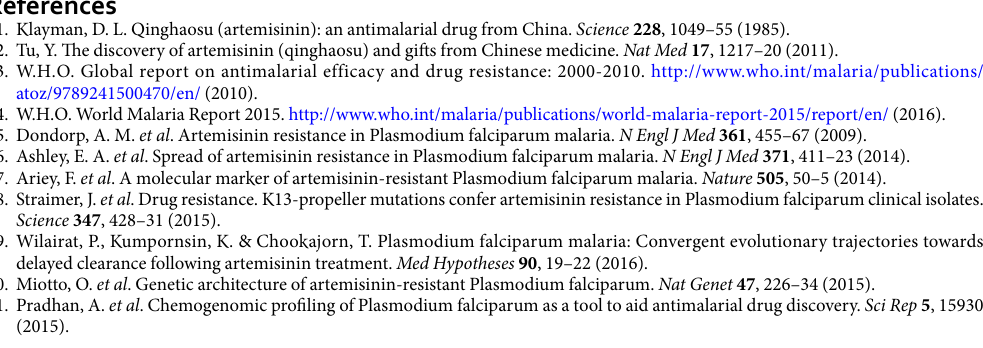
1.84 mM KH 2 PO 4 , 10 mM Na 2 HPO 4 , 137 mM NaCl, 2.7 mM KCl, pH 7.4. Isolated parasites were resuspended in Laemmli buffer containing 30% (v/v) 2-mercaptoethanol, boiled for 10 min and analysed by SDS-PAGE and western blotting. Growth curves were determined for three asynchronous clonal knockout lines by counting approximately 1000 erythrocytes per Giemsa-stained blood smear. In vitro growth inhibition (IC ) assays. 50